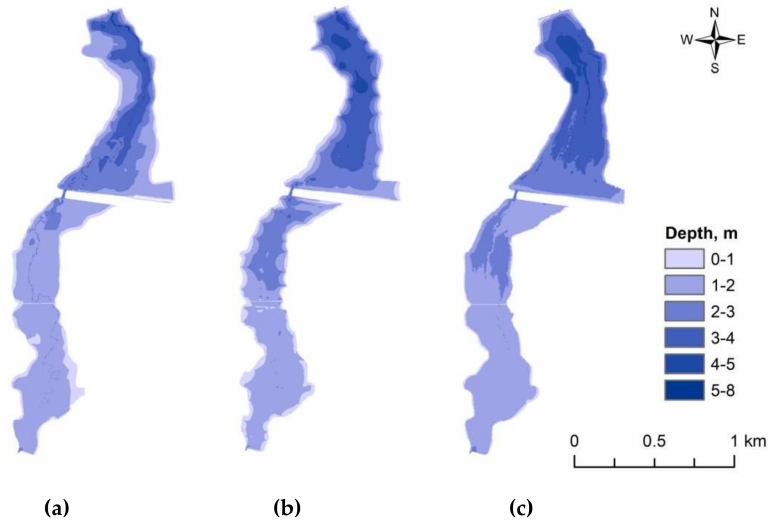
Figure 9. Analysis of depth distributions over the reservoir bottom in the Stare Miasto reservoir: ( a ) Bathymetry 2006; ( b ) bathymetry 2013; ( c ) bathymetry